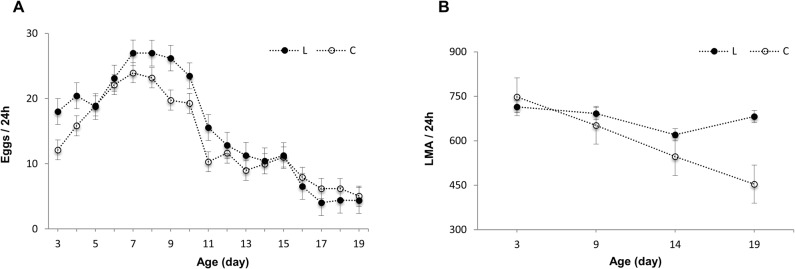
Fecundity (A) and locomotor activity (B) of the longevity-selected (black circle) and non-selected (white circle) control lines.Daily fecundity is expressed as the average number of eggs laid in 24 hours. Repeated-measures ANOVA showed that the 3- and 9-day-old L females were 48% (P = 0.02) and 32% (P = 0.01) more fecund, respectively, than their corresponding C lines. Levels of locomotor activity are represented as the average sum of movements in 24 hours. Tukey’s post-hoc comparisons showed a major difference between the locomotor activity of the L and C lines at 14 (P = 0.03) and 19 (P < 0.0001) days of age. Error bars indicate standard error of the mean.